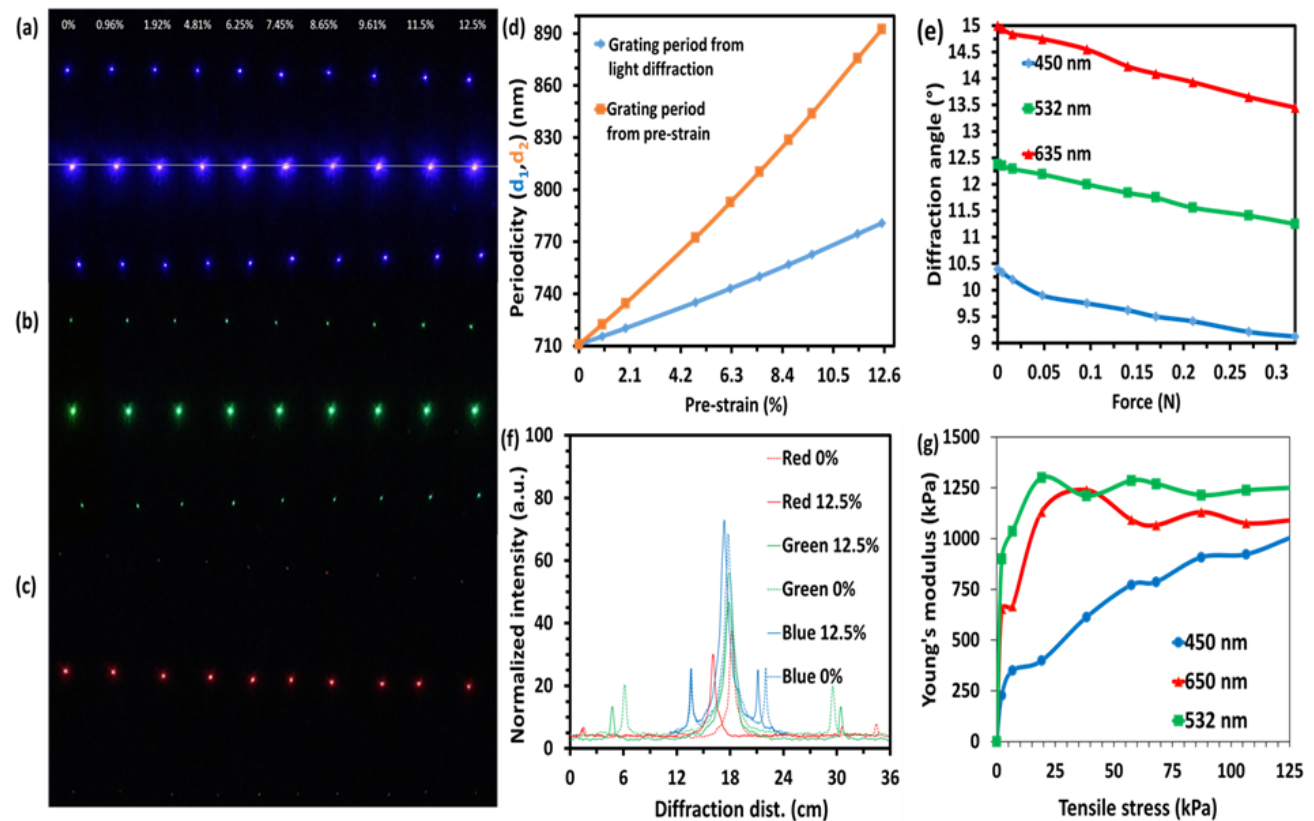
Figure 4. Experimental results of flexible periodic gratings during various light illuminations under various stress/strain levels. ( a – c ) Captured diffraction patterns with a digital camera from the image screen obtained by illuminating blue (450 nm), green (532 nm), and red (650 nm) monochromatic lights, respectively, through polymerized periodic gratings, stretched gradually through specific weight suspensions. ( d ) Measured grating period (nm) with respect to applied load (strain) by transmitting a blue (450 nm) light beam through periodic gratings and the grating period calculated from pre-strain. ( e ) Variations in diffraction angles on the diffraction patterns with applied load (force) for blue, green, and red lasers. ( f ) Normalized intensity distribution against diffraction distance (four orders of diffraction) during minimum and maximum stretching (strain) of the flexible periodic gratings under various light illuminations. ( g ) Tensile stress (kPa) versus Young’s modulus (kPa) with blue (450 nm), green (532 nm), and red (650 nm) monochromatic light sources.